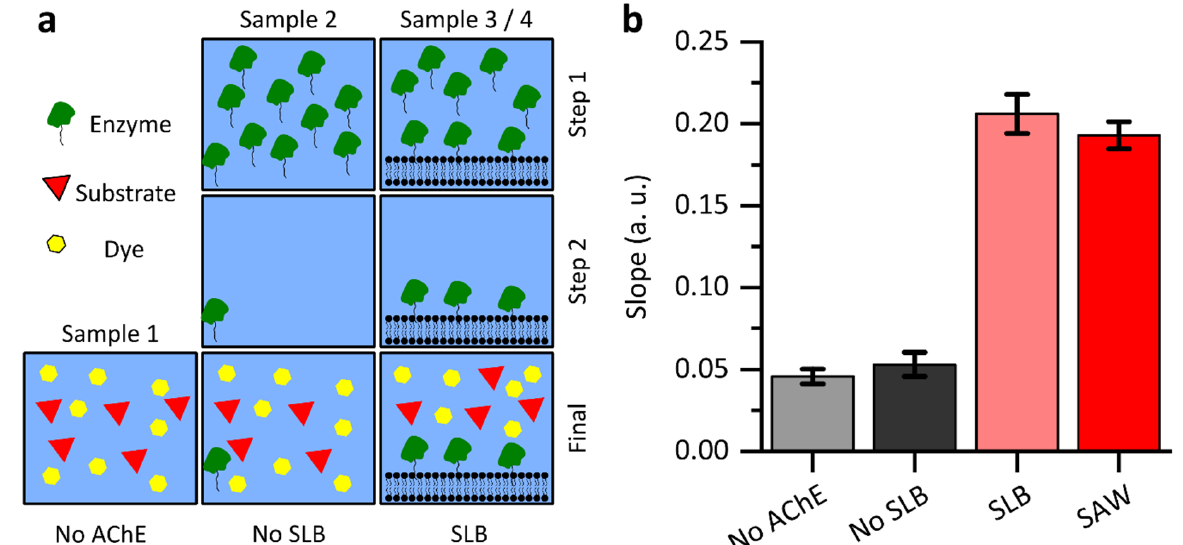
Figure 4. Determination of enzyme binding to SLB and influence of a SAW standing wave field on enzyme activity. ( a ) Preparation steps of the different samples. ( b ) Measurement of absorbance after 1 h by taking out 50 μ L. Sample 2 (no SLB) shows nearly the same absorbance as Sample 1 (no AChE). Sample 3 (SLB), on the other hand, shows a much higher absorbance. This suggests that the enzyme is bound to the SLB. Sample 4 (SAW) shows almost the same absorbance as Sample 3 (SLB). Therefore, there is no significant difference due to the SAW treatment. Error bars represent the standard deviation.